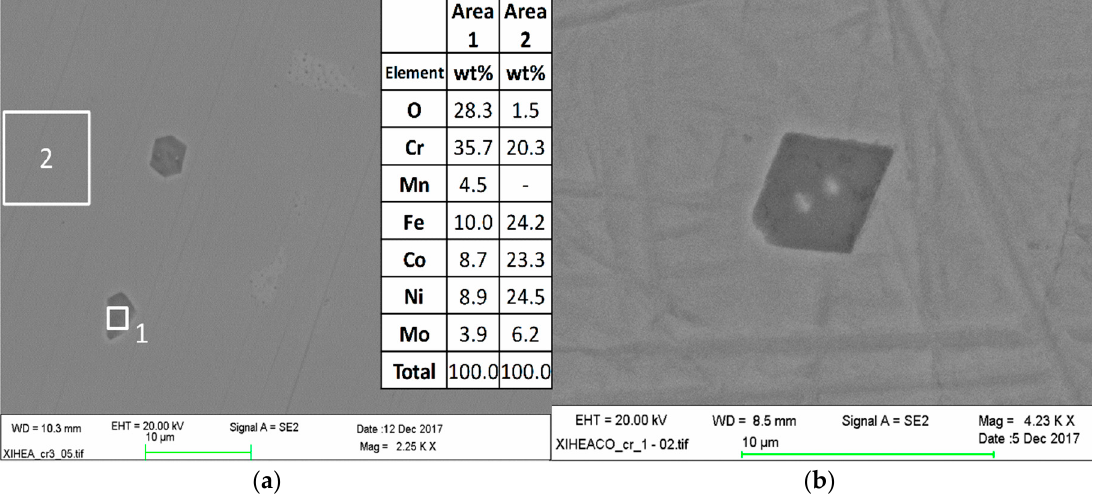
Figure 1. ( a ) Scanning electron microscopy (SEM) image showing the microstructure of the as-cast CoCrFeNiMo material revealing segregated compounds within the bulk and a table with energy-dispersive spectroscopy (EDS) analyses of areas highlighted with white boxes in image ( a ); and ( b ) SEM image of the compound at higher magnification.